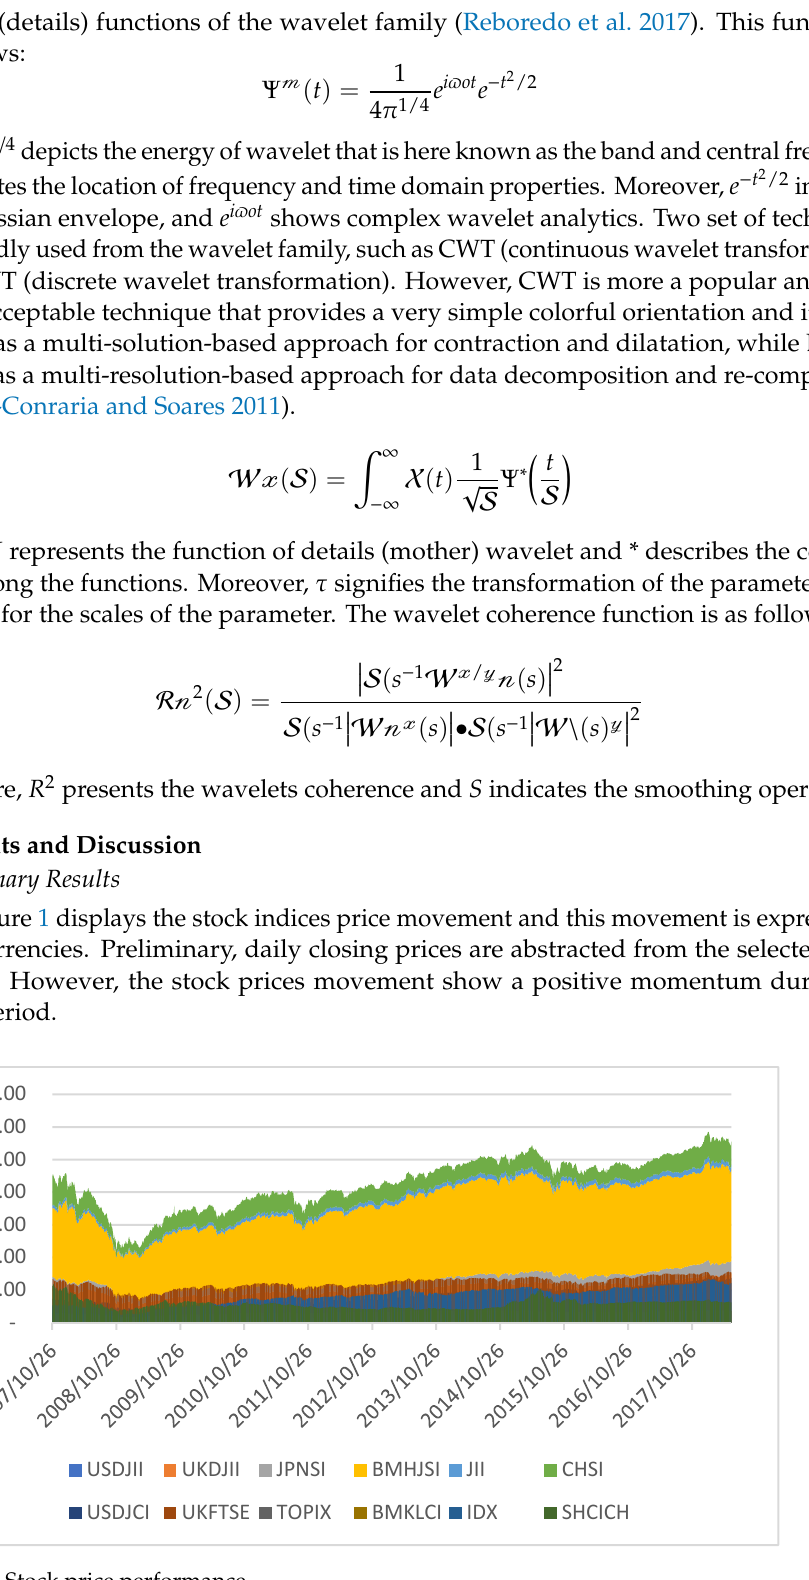
Figure 1. Stock price